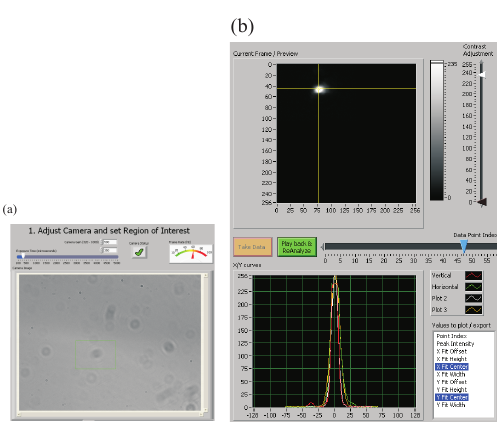
Figure 18. (Color online) Display of the LabVIEW interface used to record and analyze CCD images of the trapped beads. ( a ) Image of beads suspended in solution. ( b ) The upper frame shows the image of a 2 µ m diameter trapped bead. The corresponding intensity profile is displayed in the lower frame.